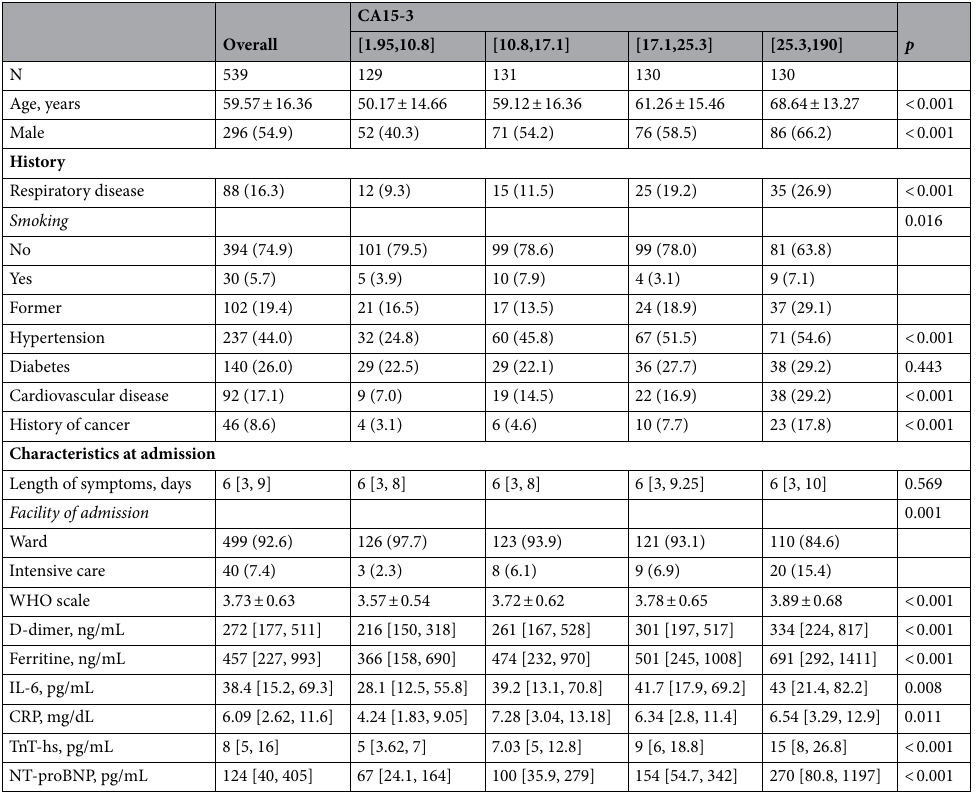
Table 1. Distribution of the clinical characteristics at baseline by quartiles of CA15-3.